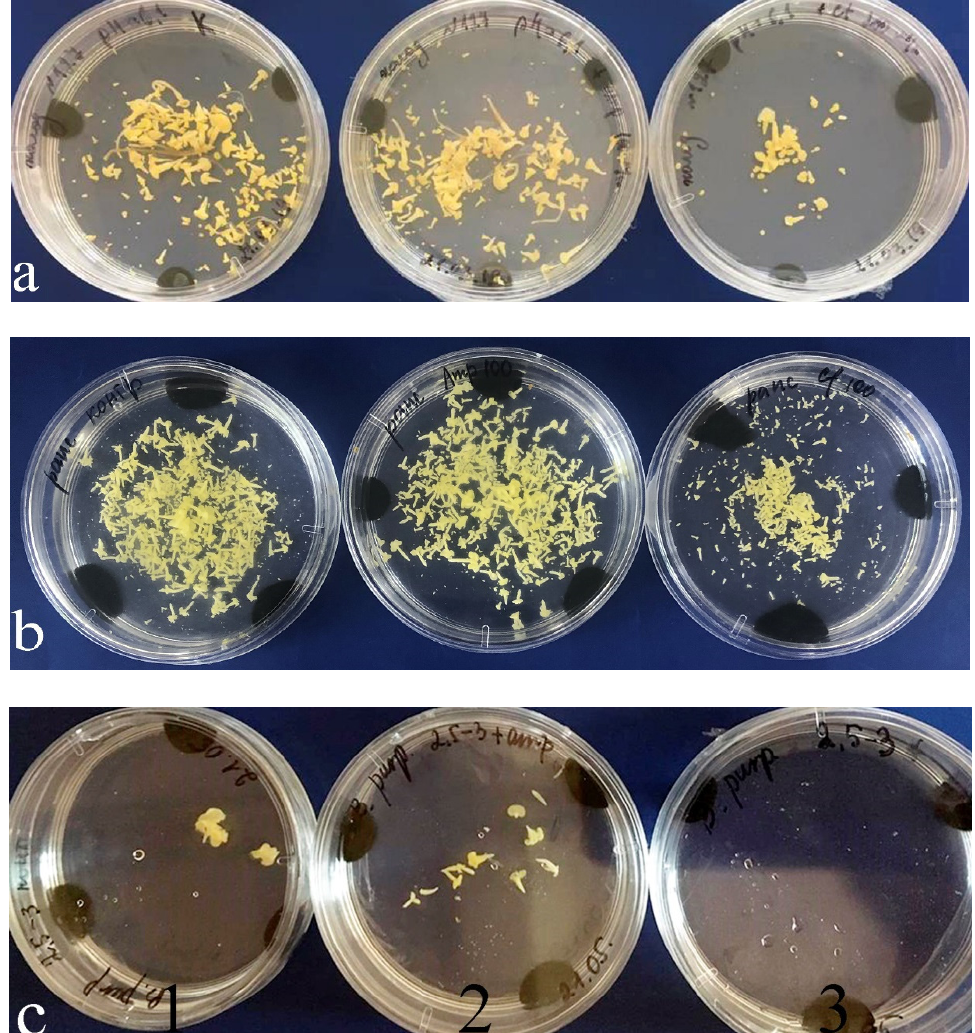
Figure 6. Effect of antibiotics on the embryogenic activity of the Brassica plants in in-vitro culture: ( a ) B. oleracea; ( b ) B. napus ; ( c ) B. rapa . 1, control medium without antibiotics; 2, medium with ampicillin; 3, medium with cefotaxime.